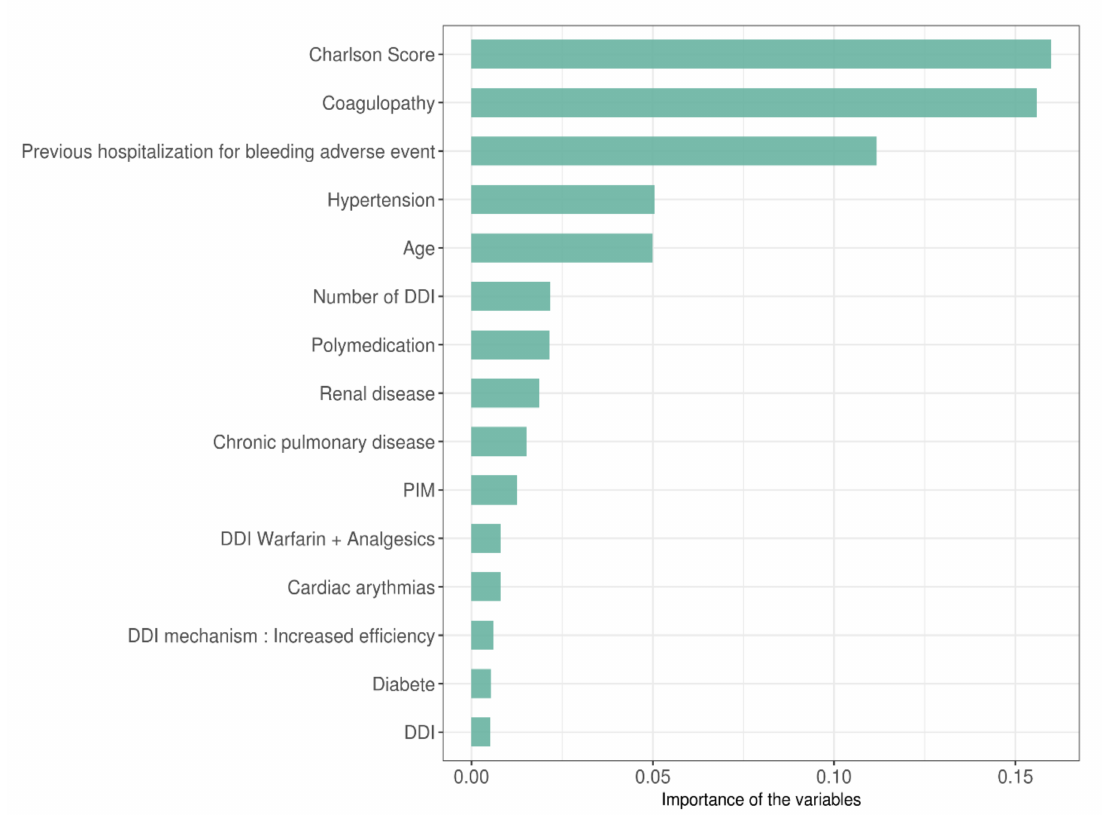
Figure 4. Importance of the variables selected by XGBoost algorithm ranked by importance